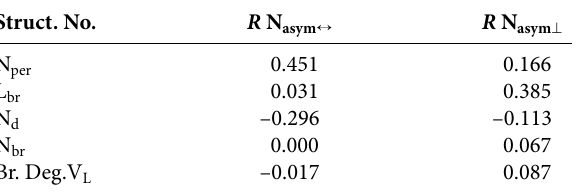
Table 2. Correlation of the Asymmetry Numbers with the number of branches (N br ), with the peripheral number (N per ), with the dis- tance number (N d ), with the size of the largest branch (L br ), as well as with the branching degrees of octane isomers (Br. Deg.V L ). Struct.